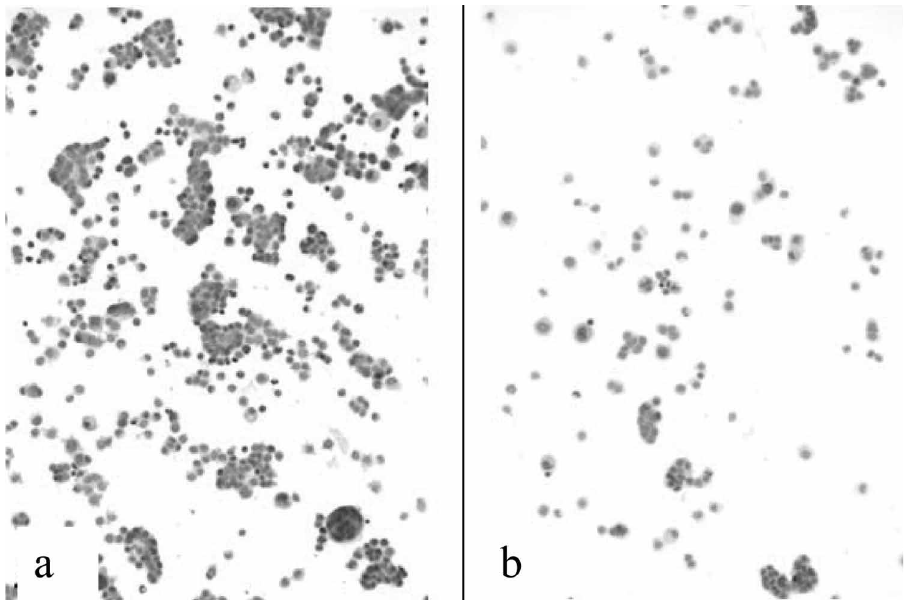
Figure 1 B19 VP2 empty capsid-induced VTB aggregation. Equal numbers of VTB (2.5 6 10 5 ) were incubated with (a) or without (b) 15 m g/ml unlabeled B19 VP2 empty capsid before cytospin preparation and hematoxylyn